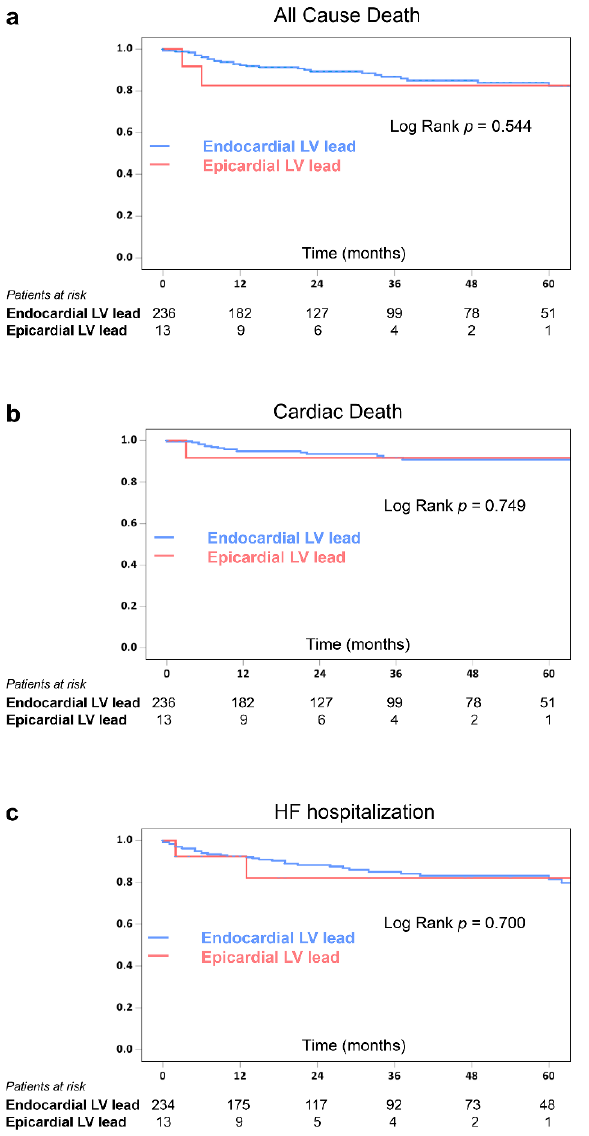
Figure 4. Kaplan–Meier survival curves of time to all-cause death ( a ), cardiac death ( b ), and HF hospitalization ( c ) in the Endocardial and Epicardial groups. HF = heart failure, LV = left ventricle.